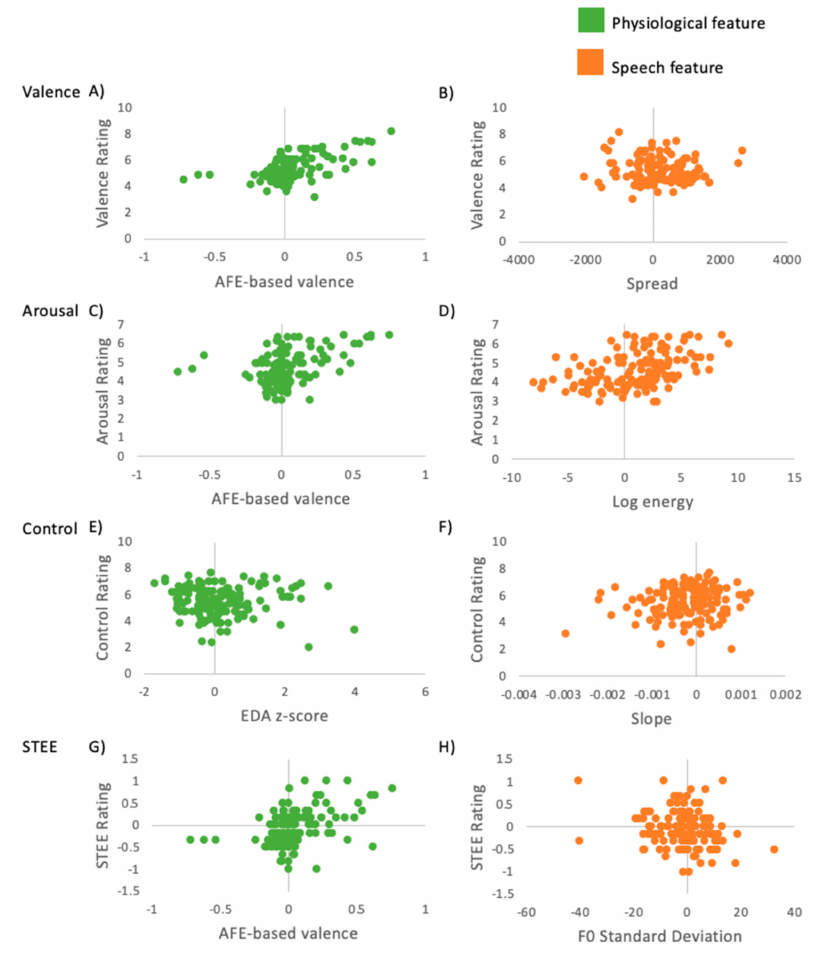
Figure 7. Boxplots of evaluator rating and select physiological and speech features.